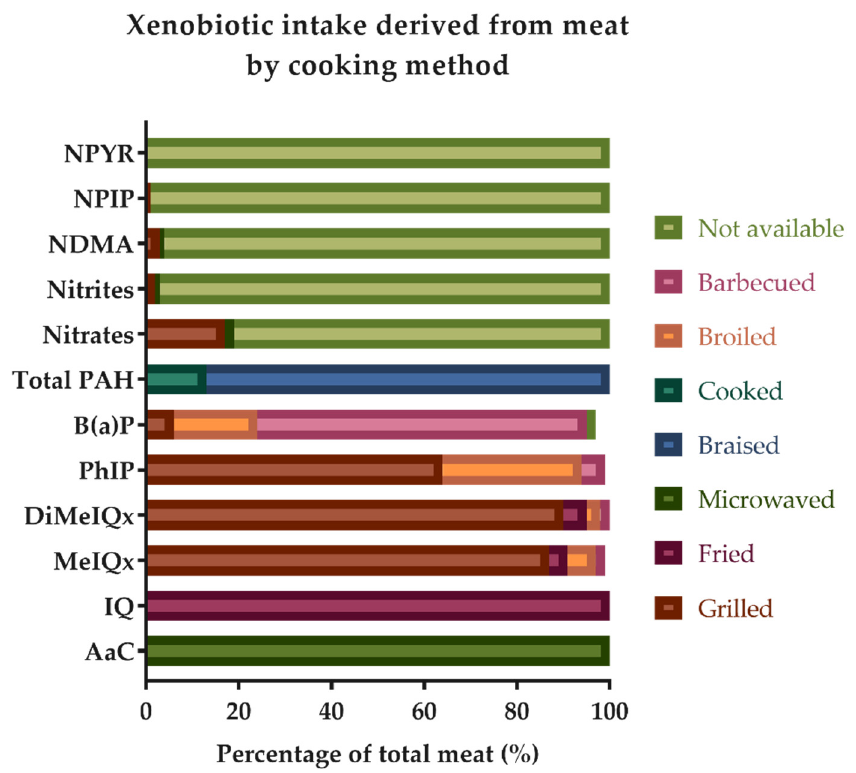
Figure 2. Impact of meat cooking method over the xenobiotic intake in the study sample (percentages may not sum to 100% because of rounding). The label “Cooked” was used by the authors Jakszyn, P. et al. as a general cooking method descriptor. A α C, amino-alpha-carboline; IQ, 2-amino-3-methylimidazo (4,5,f) quinoline; MeIQx, 2-amino-3,8 dimethylimidazo (4,5,f) quinoxaline; DiMeIQx, 2-amino-3,4,8 trimethylimidazo (4,5,f) quinoxaline; PhIP, 2-amino-1-methyl-6-phenylimidazo (4,5,b) pyridine; B(a)P, benzo (a) pyrene; DiB(a)A, dibenzo (a) anthracene; Total PAHs, total polycyclic aromatic hydrocarbons; NDMA, N -nitrosodimethylamine; NPIP, N -nitrosopiperidine; NPYR, N -nitrosopyrrolidine.